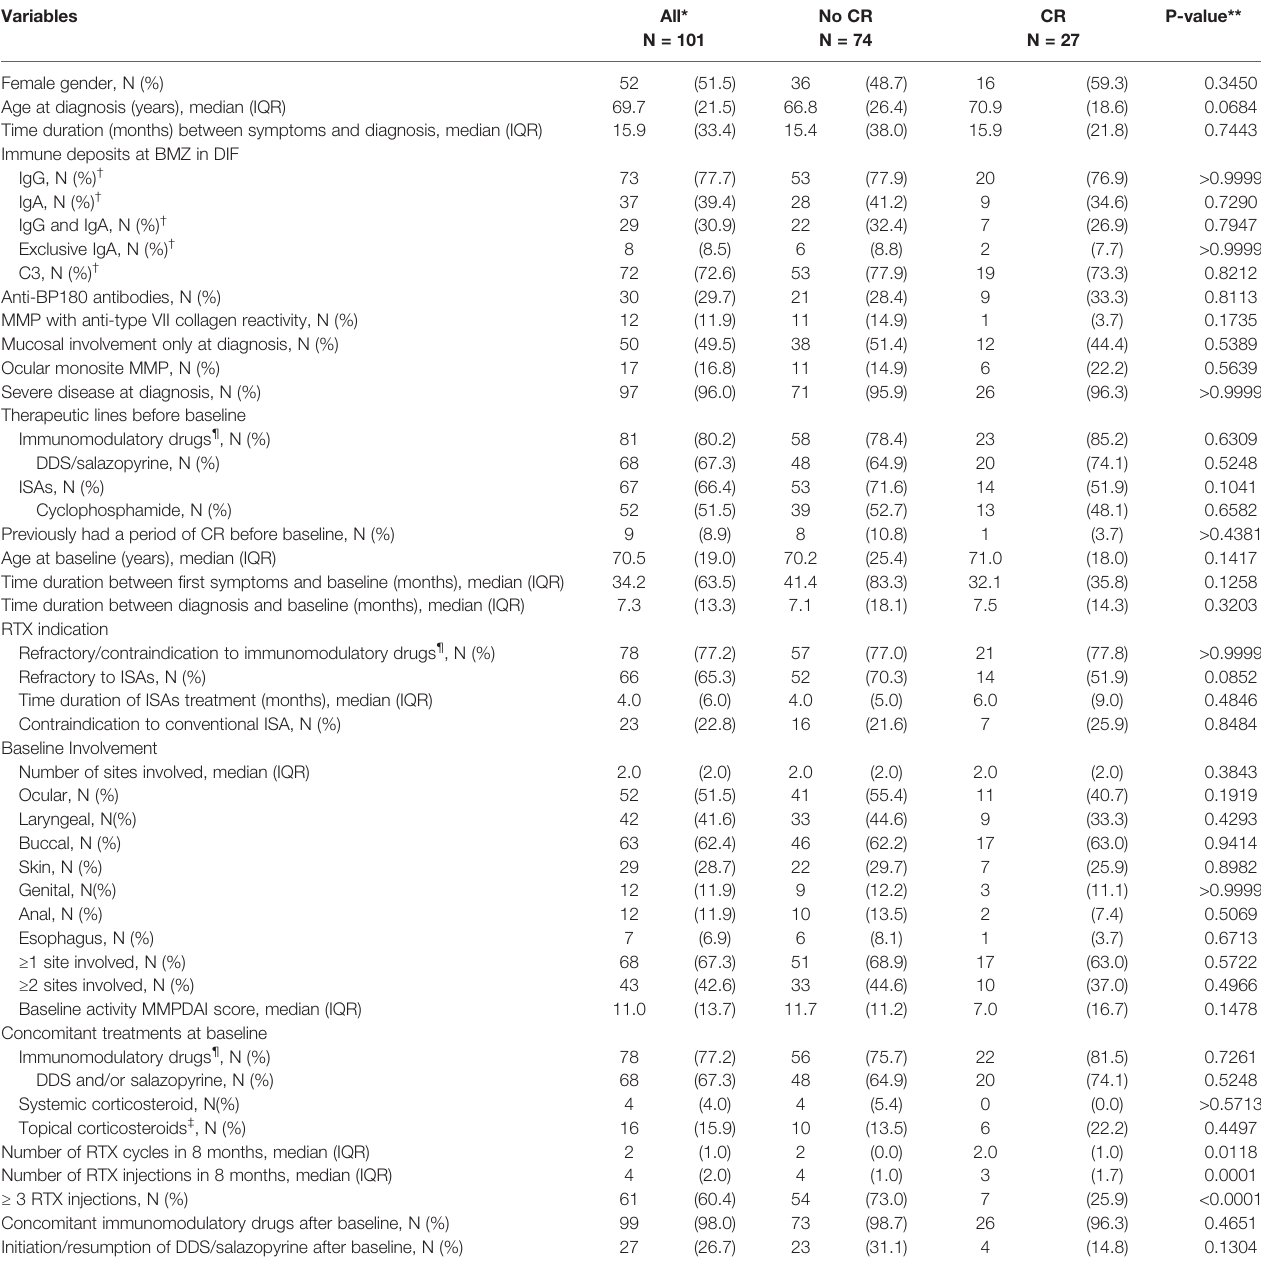
TABLE 5 | Univariate analysis: factors associated with complete remission at 8-month follow-up in 101 patients with MMP.